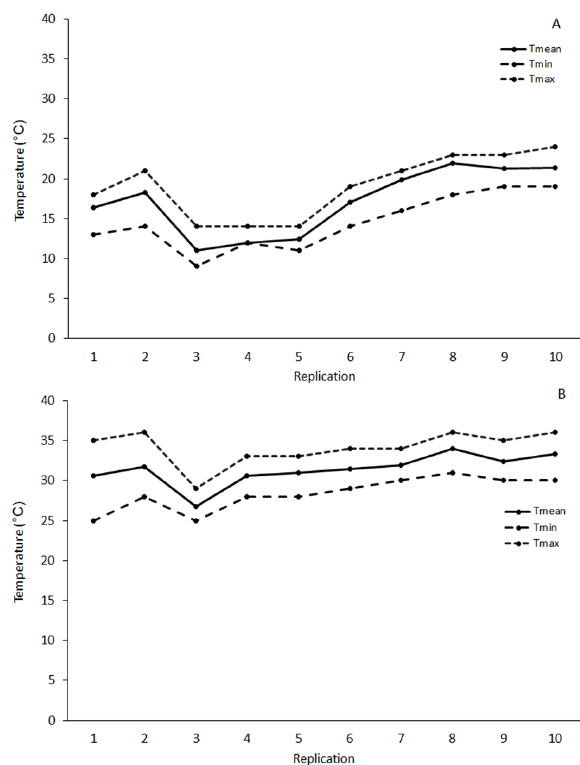
Figure 1. Mean (Tmean), minimum (Tmin) and maximum (Tmax) temperatures during spring ( A ) and summer ( B ) field cage trials. Tmean was calculated as the mean temperature of the eight hourly records in each test date (replication) using an analog thermometer.